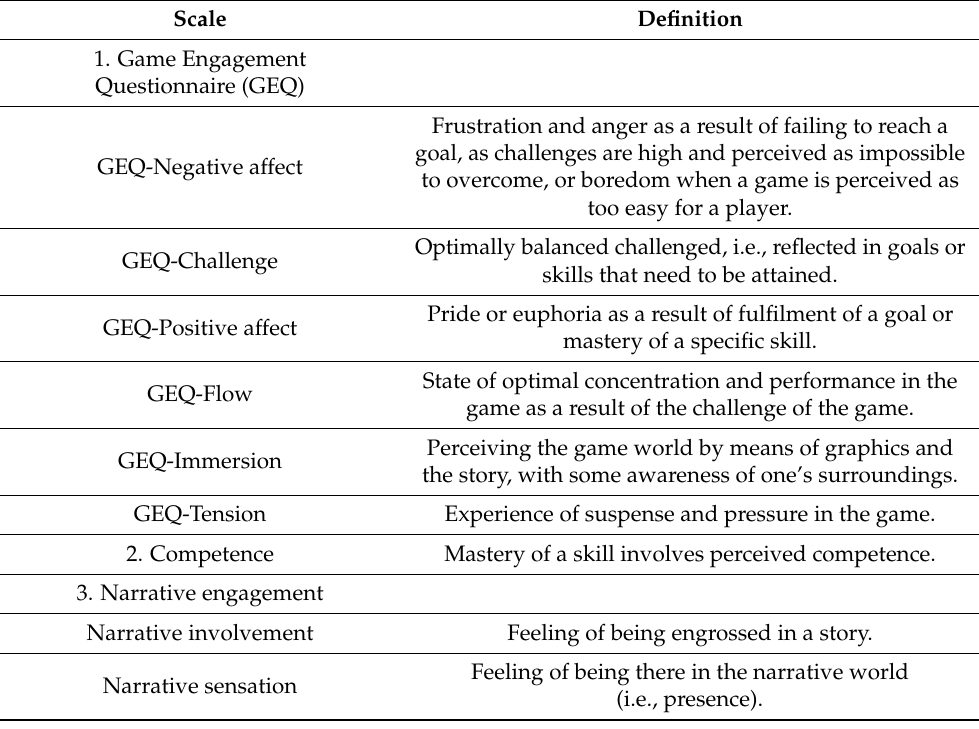
Table 1. Definitions of included